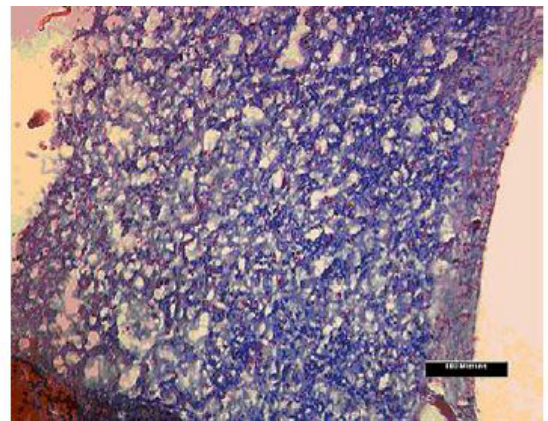
Figure 6. Electrospun collagen/elastin scaffold showing extensive SMC infiltration, and a highly dense distribution of cells across the entire cross-section of the scaffold. Reprinted with permission from Frontiers in Bioscience